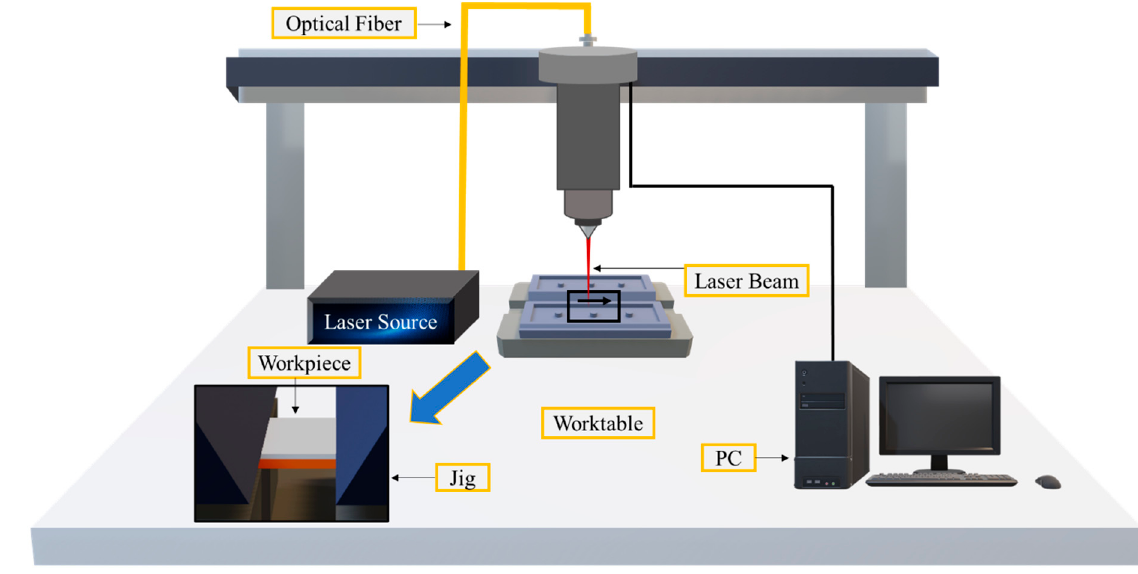
Figure 1. Schematic of experimental setup.